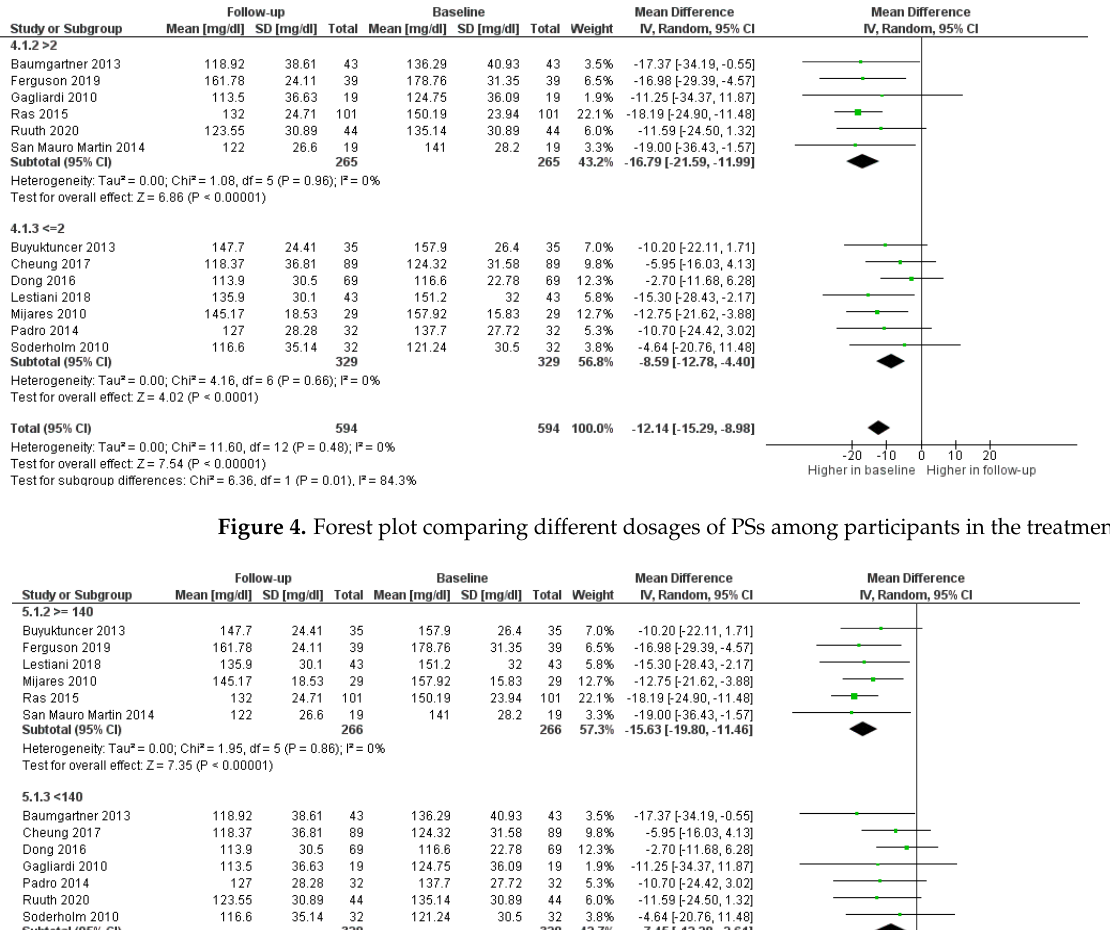
Figure 4. Forest plot comparing different dosages of PSs among participants in the treatment groups.